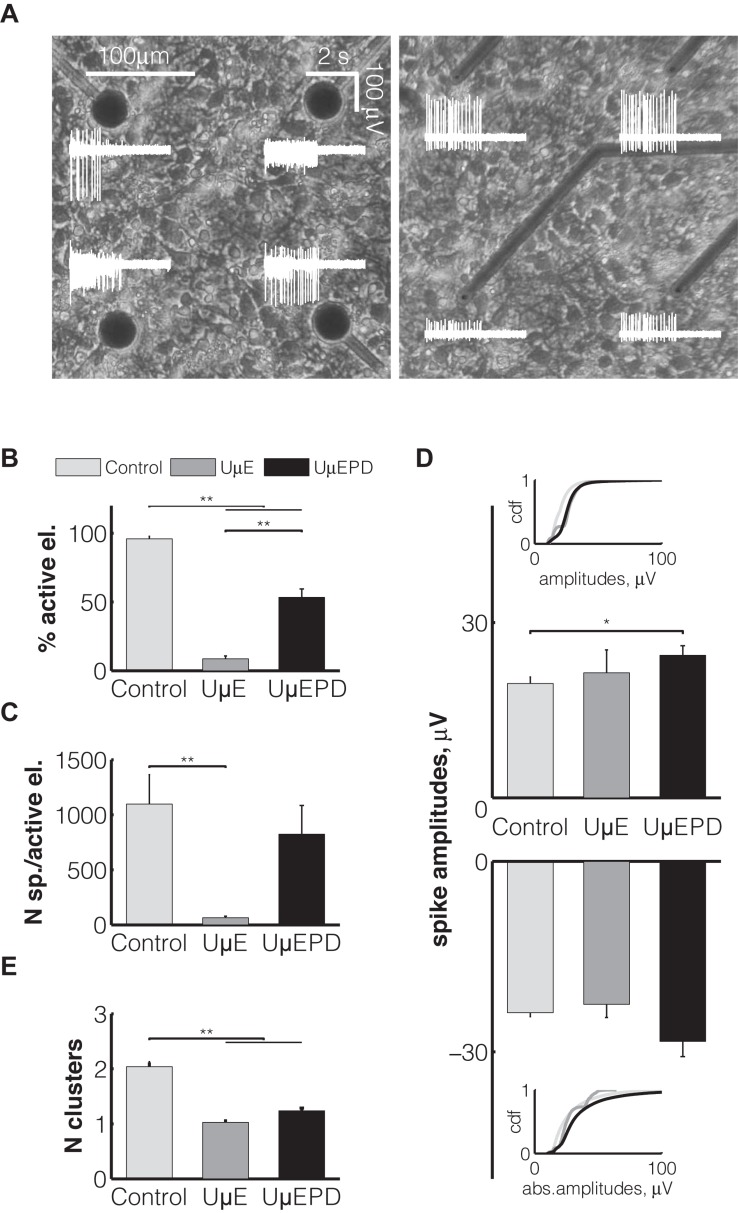
Elementary properties of different types of electrodes: conventional planar (light gray, n = 12 MEAs), gold ultramicroelectrodes (UμE, dark gray, n = 6 MEAs), PEDOT:PSS ultramicroelectrodes (UμEPD, black, n = 10 MEAs). Representative phase-contrast micrographs show cortical cells at the second week after plating on the glass surface with conventional planar electrodes (A, left) and with PEDOT:PSS ultramicroelectrodes (A, right). The white traces represent the electrical activity detected by the corresponding electrodes within an interval of 4 s. The percentage of active electrodes is represented as percentage of those electrodes detecting signals (B). The average number of spikes per active electrode is displayed in (C), together with the average value of detected amplitudes with positive (top) and negative (bottom) deflections (D). The average number of different spike waveforms (clusters) detected by single electrode is displayed in panel (E). Data are shown as the mean ± SEM and statistical significance between groups was assessed using a two-way ANOVA and post-hoc Fisher’s procedure.